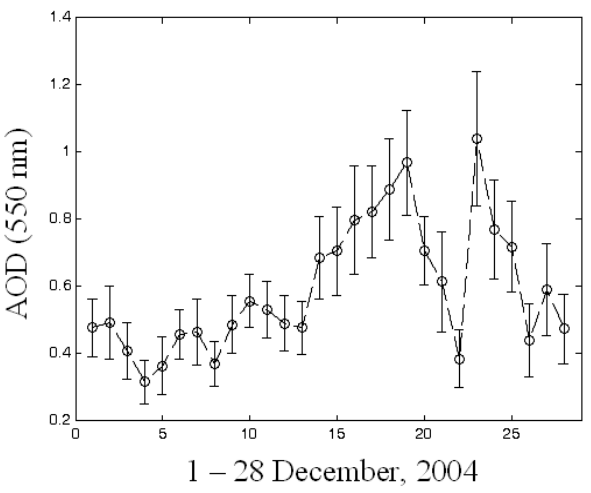
Fig. 3. Daily variations of AOD (550nm) averaged over the Ganga basin during